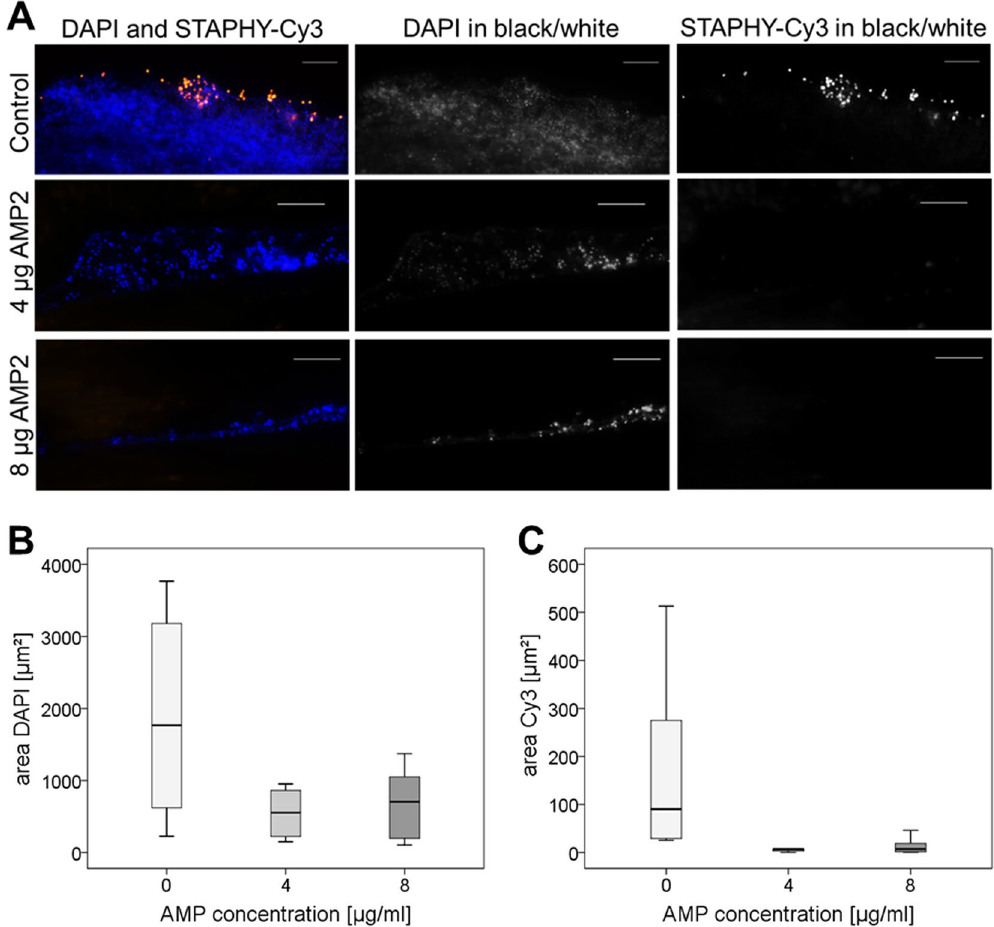
Figure 6. Fluorescence in situ hybridization (FISH) of S. epidermidis biofilms grown on polyurethane (PU) waver treated with 0, 4 or 8 µ g/ml AMP2. ( A) On the left hand, the panel shows the nucleic acid stain DAPI (blue) overlaid with the Cy3-labeled Staphylococcus- specific FISH-probe STAPHY (orange) for each group. The middle and right panels show either the separate DAPI or FISH Cy3 images in black and white of the respective colored image. AMP2 treatment led to a dramatic reduction of total biofilm area and fraction of FISH positive bacteria. Note also the altered fragmented appearance of the AMP treated biofilms. Scale bar = 10 µ m. Pictures of 10 random areas per group were taken and results of digital images analysis are shown. (B) Total biofilm area (stained with DAPI). (C) Area of the FISH-positive bacteria (STAPHY-probe labelled with Cy3). n = 10 pictures per group. Data are shown as median with 25 and 75